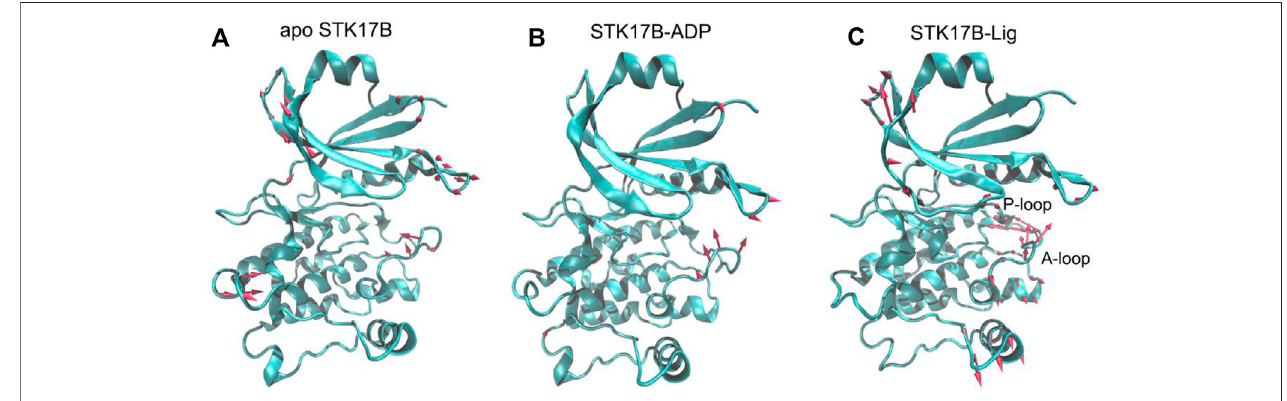
FIGURE 5 | The motion of the fi rst principal component (PC1) for the apo (A) , ADP-bound (B) , and ligand-bound (C) systems. The red arrows represent the direction, with length proportional to the intensity of the